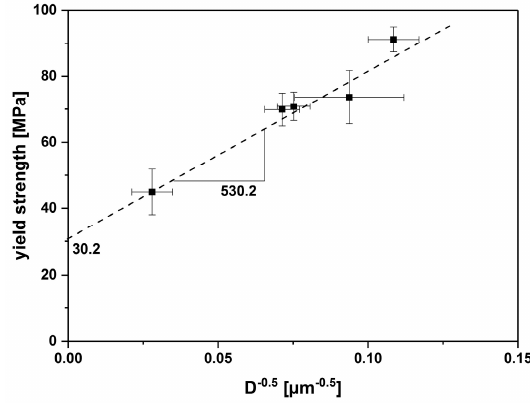
Figure 6. Hall-Petch plot of yield strength over the reciprocal of the square root of grain size D following Equation (A1) in Appendix A. (The standard deviation of the square root D is given in percentage of standard deviation of D and a minimum square root fit was applied without considering the standard deviations).